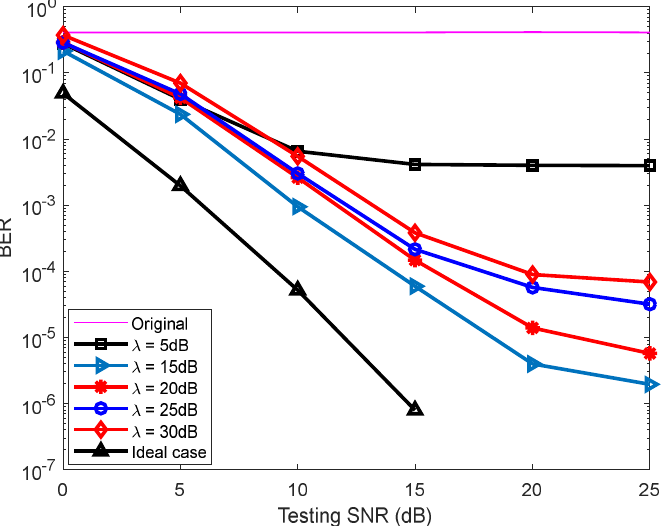
Figure 7. BER performance comparison of the proposed scheme under the NLOS U 1,5 .